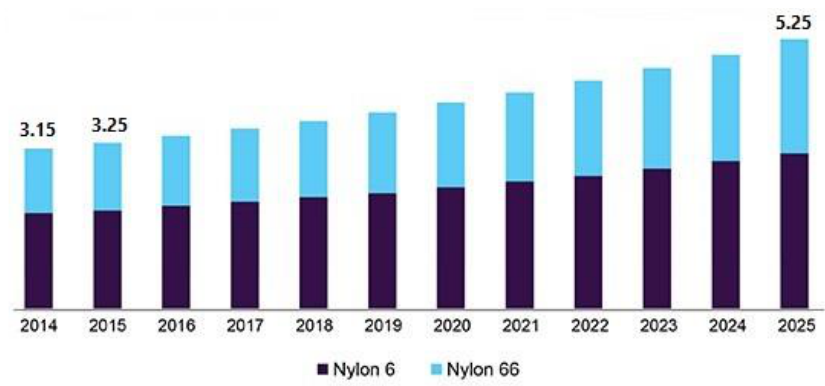
Figure 1. USA nylon 6 and 66 market size, by product, 2014 – 2025 (USD Billion) [source: